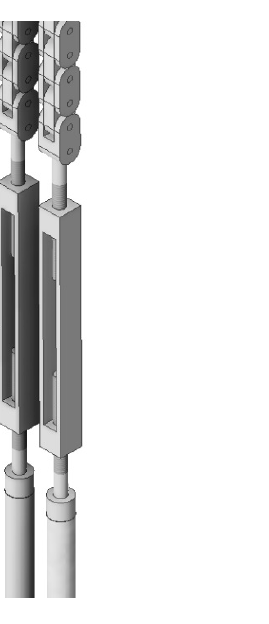
Figure 14. Detail of the chain of links and tensors of the transmission.